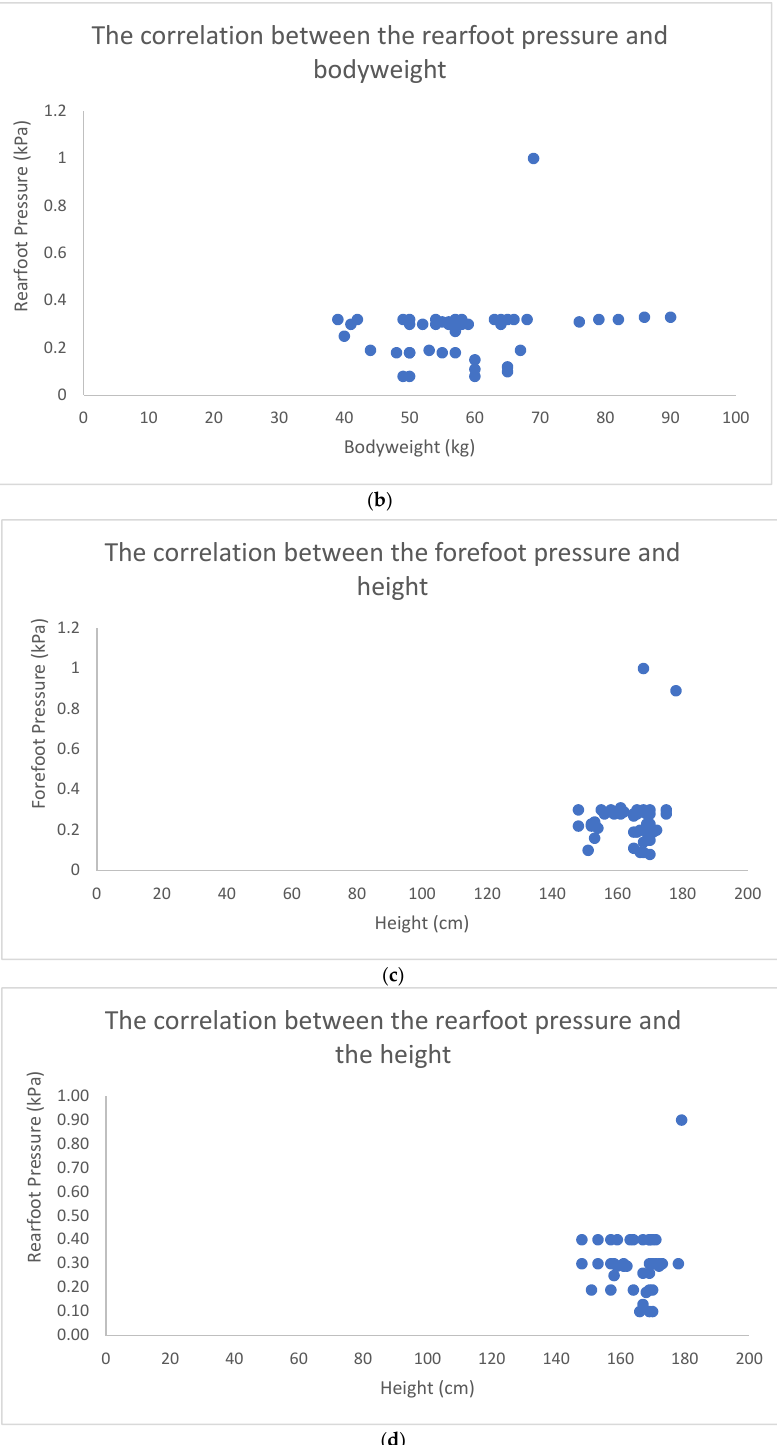
correlation between the forefoot pressure and bodyweight